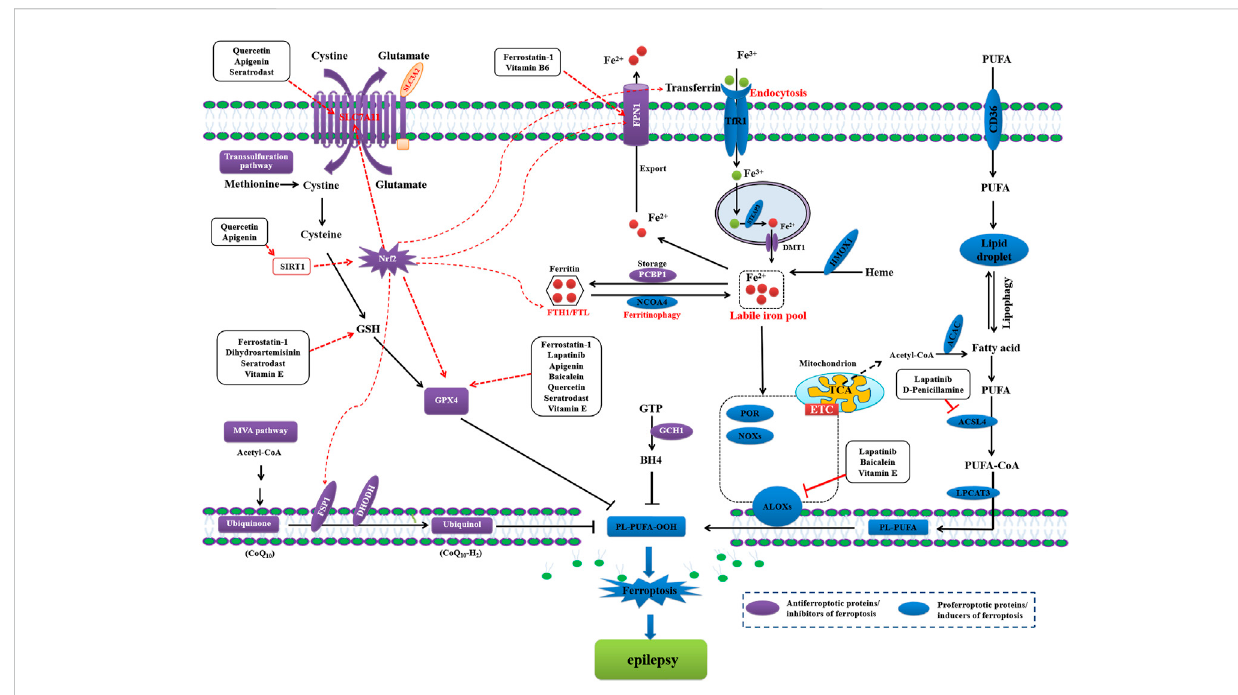
Pharmacological inhibition of ferroptosis to treat